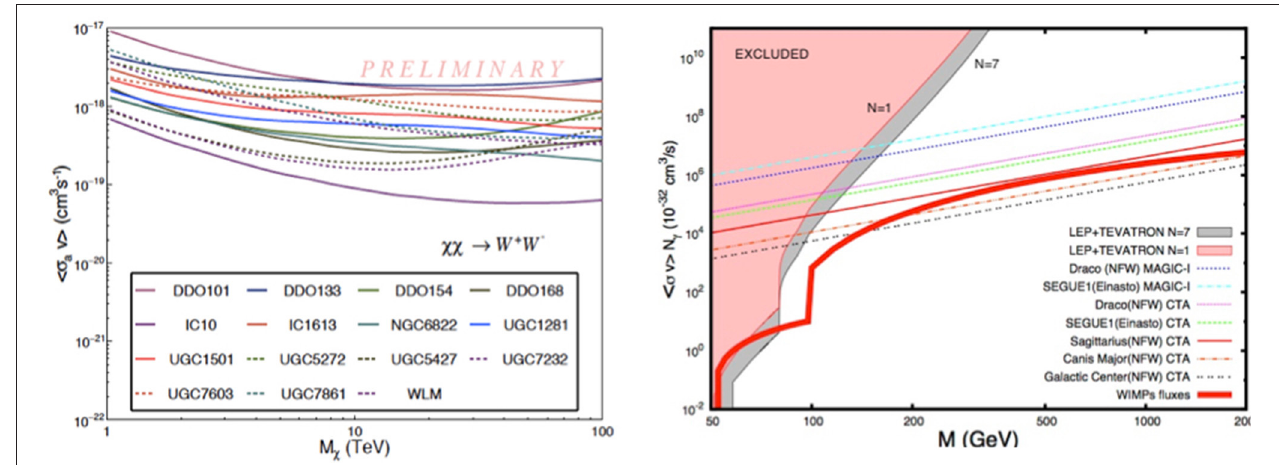
FIGURE 2 | Left : Figure from Cadena et al. (2018). Constraints on the DM mass and annihilation cross-section by the study of several dwarf irregular galaxies at TeV energy scale, with 1-year of data of the HAWC observatory. Right : Figure from Cembranos et al. (2012a). Study of detectability of branon DM with Cherenkov